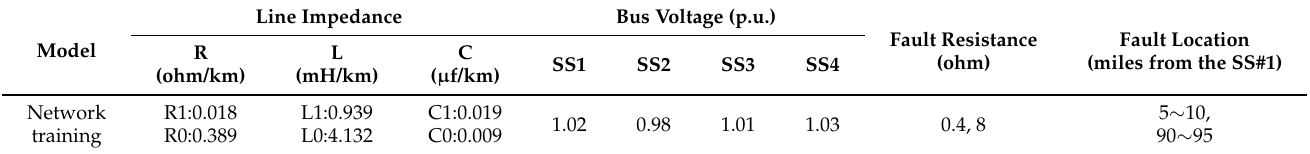
Table 5. Input parameters for additional